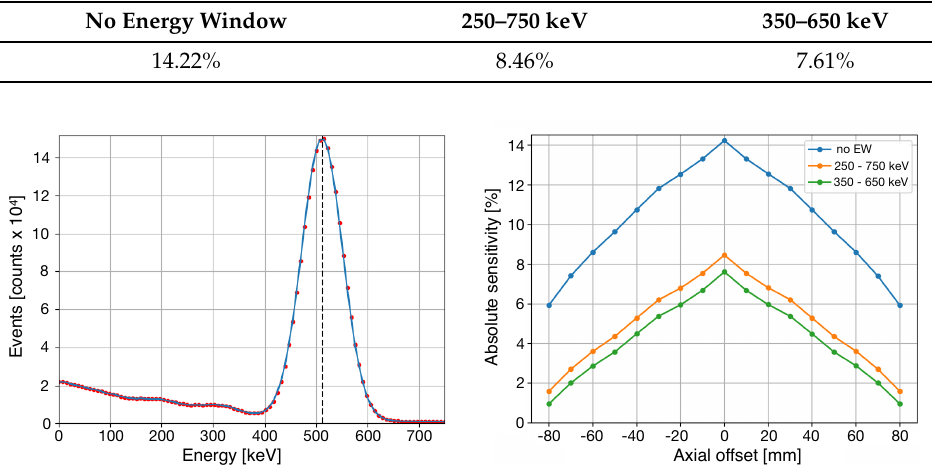
Table 5. Sensitivity results for different energy windows.